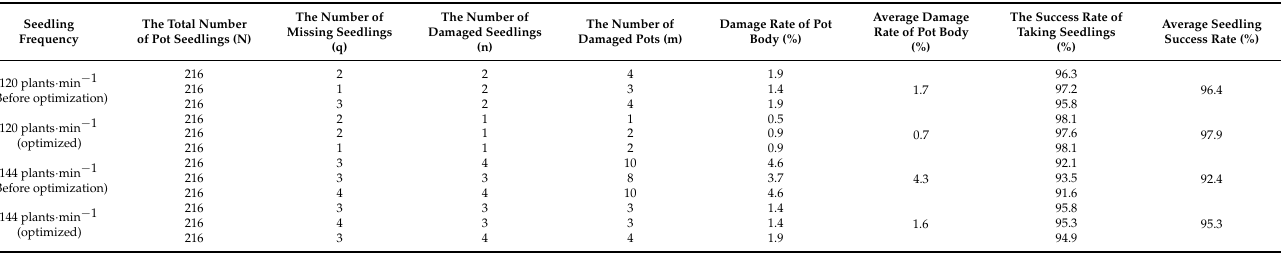
Table 9. Test results of seedling